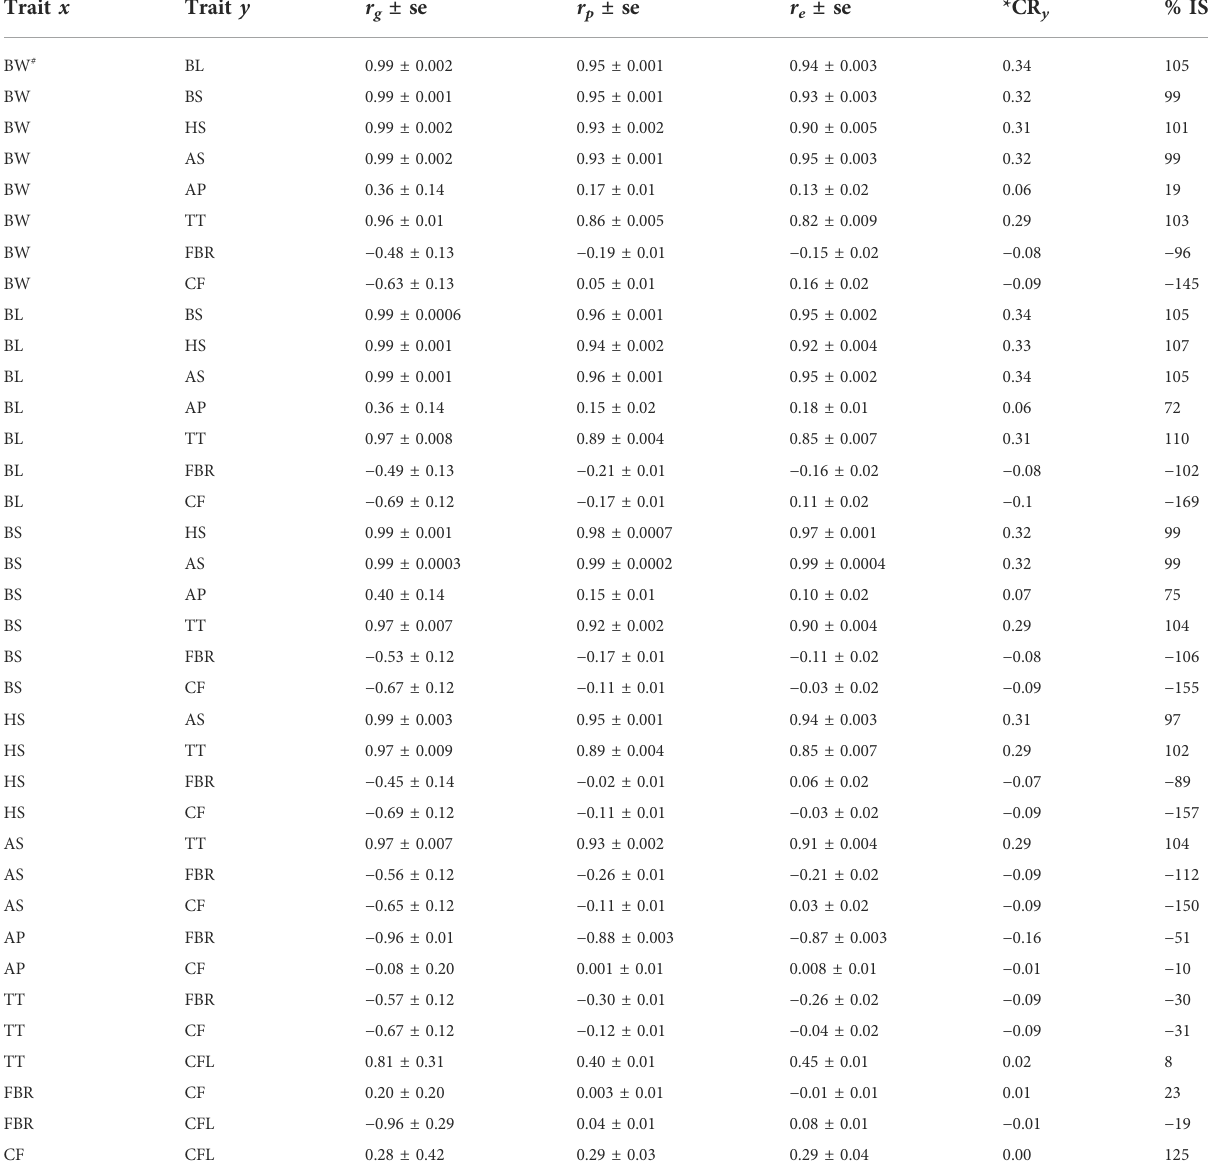
TABLE 4 Genetic ( r g ± se), phenotypic ( r p ± se), and environmental ( r e ± se) correlations among traits and extent of indirect selection response in correlated traits. Trait